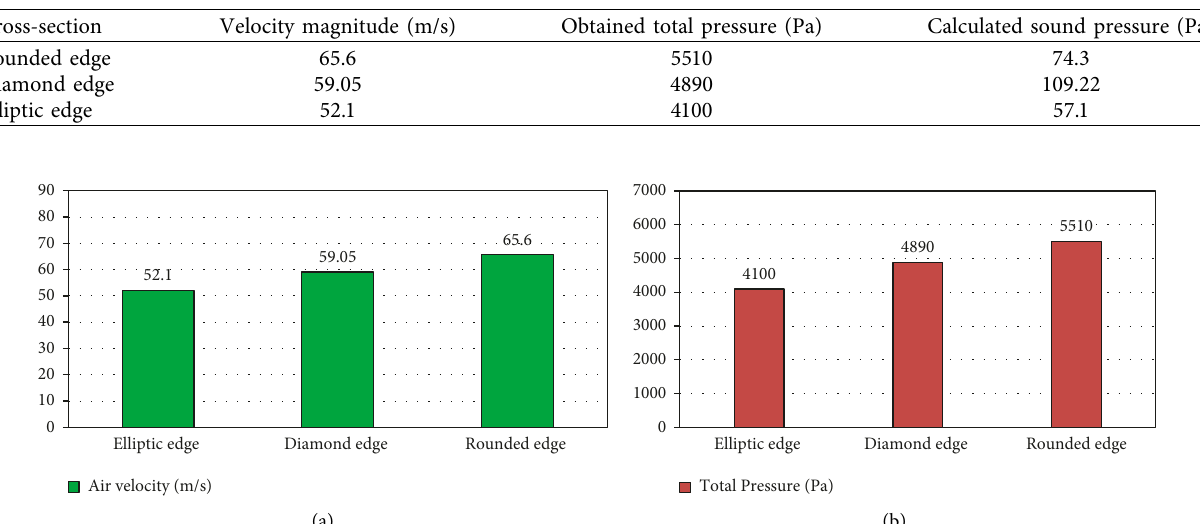
Table 2: Comparison of the computational results of different panhead cross-sections.